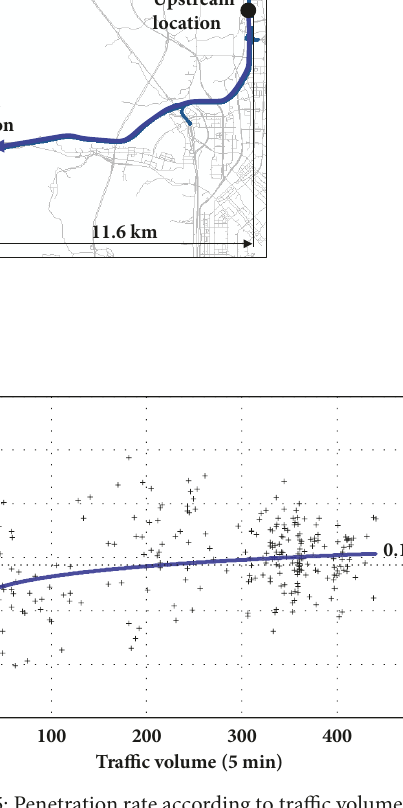
Figure 4: Temporal variation of traffic and probe volumes.